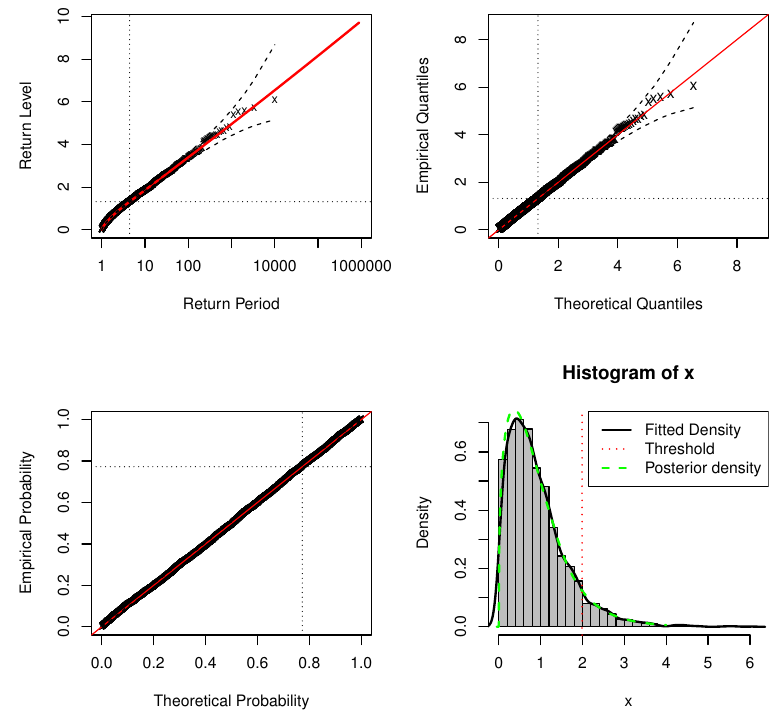
Figure 6. Standard model fit diagnostics for the DPMW-PPR model fitted to the simulated data with n = 5000. (The top left corner is the return level plot, the top right corner is the quantile plot, the bottom left corner is the probability plot, and the bottom right corner is the density